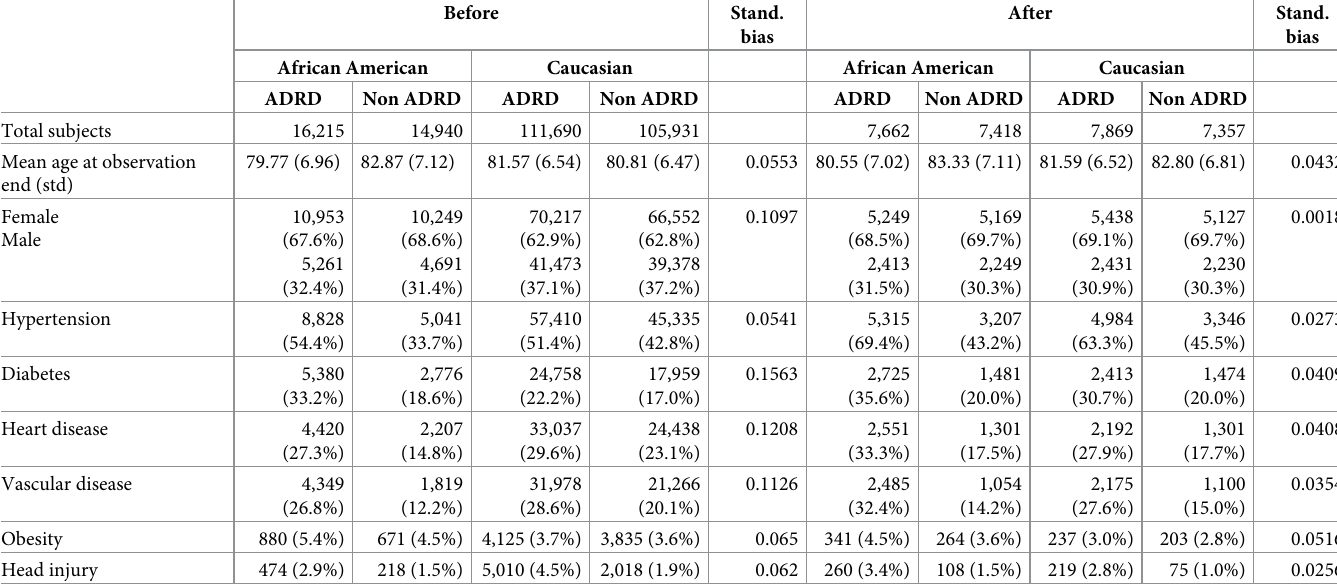
Table 2. Cohort demographics. Distribution of comorbidities with a known risk before and after matching between African Americans and Caucasians. Standardized bias = difference in the mean of a given variable between African Americans and Caucasians divided by the standard deviation in African Americans. Before Stand. After Stand. bias